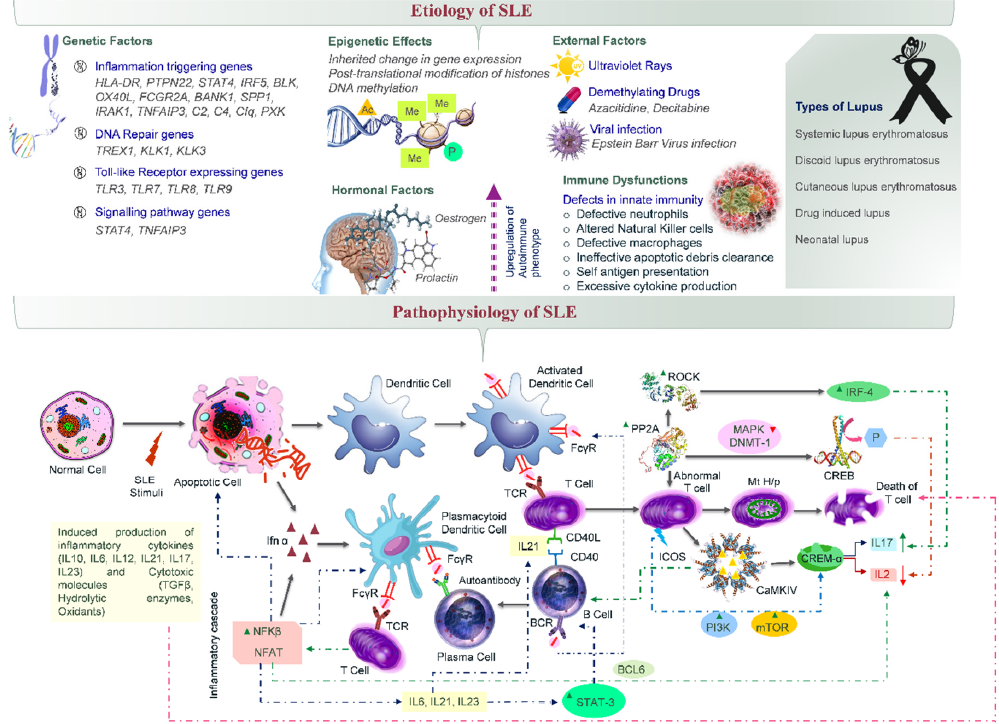
Figure 1. Etiology and pathophysiology of systemic lupus erythromatosus (SLE). Etiology of SLE includes genetic, epigenetic, hormonal, immunological and other external factors. These etiological factors act as a stimulus for inducing apoptosis of a normal cell, thereby breaking the dsDNA which in turn induces the production of interferons (Ifn- α ) [1,10]. These interferons induce the activation of plasmacytoid dendritic cells. Further, the broken DNA acts as an antigen which is presented on dendritic cells (physiologically altered with Fc γ R). Meanwhile, T cells and B cells also interact via CD40 and CD40L interaction with the DNA antigen, thereby inducing the production of autoantibodies which further induce the interaction of plasmacytoid dendritic cells and T cells [12–14]. This interaction upregulates the production of NFAT and NF κ B, both of which inhibit the production of IL-2 (an immunosuppressive cytokine) and induce the production of BCL6, IL6, IL21 and IL23. These cytokines further